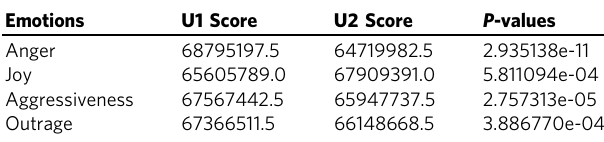
Table 2 U1, U2, and P -value score on various